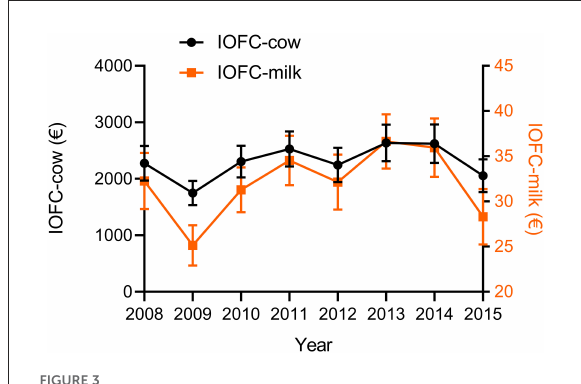
FIGURE3 Average income over feed cost per cow (IOFC-cow) and per 100kg milk (IOFC-milk) for the years 2008 to 2015.